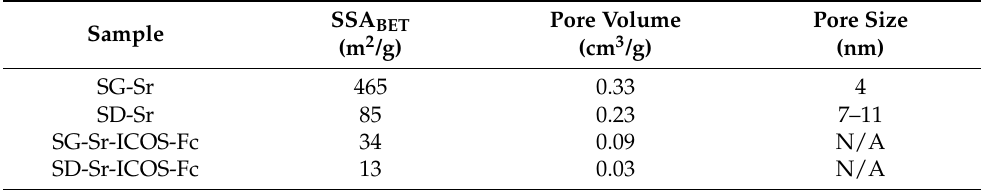
Table 1. SSA BET and total pore volume of SG-Sr, SD-Sr, SG-Sr-ICOS-Fc, and SD-Sr-ICOS-Fc.